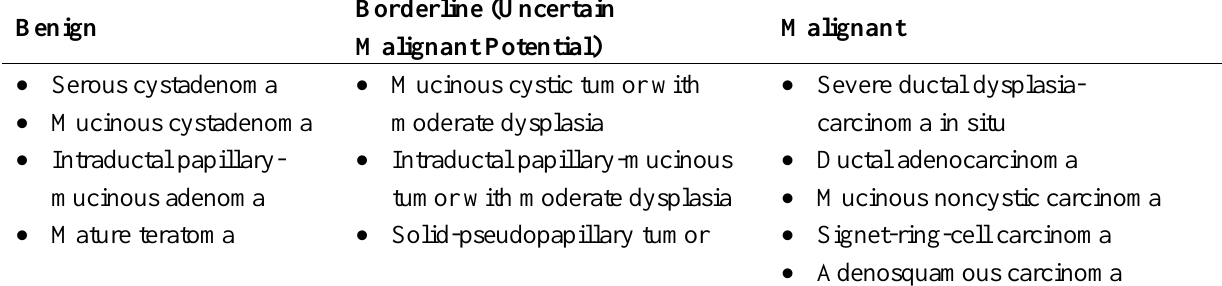
Table 1. Histological classification of exocrine pancreatic epithelial tumors [143]. Borderline (Uncertain Benign Malignant